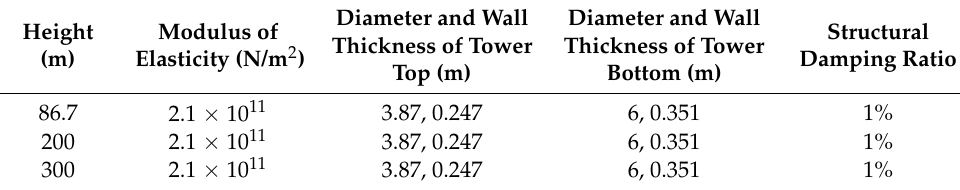
Table 4. Ultra-high flexible tower